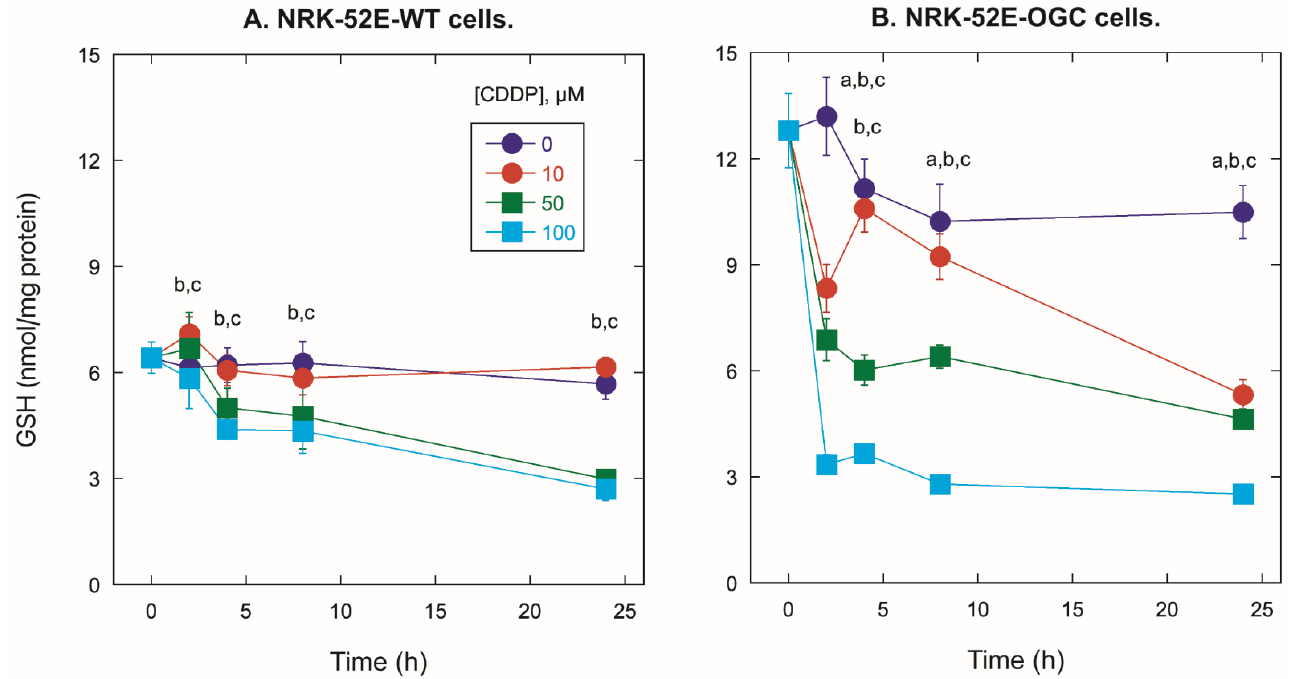
Figure 5. Time and concentration dependence of effects of CDDP on total cellular GSH concentration. Concentrations of total cellular GSH were determined in cells grown on collagen-coated T-25 flasks. After detachment at the indicated times by brief treatment with trypsin/EDTA, GSH content was determined by ion-exchange high-pressure liquid chromatography after derivatization with iodoacetic acid and 1-fluoro-2,4-dinitrobenzene. Results are means ± SEM of measurements from 3 separate cell cultures for NRK-52E-WT cells ( A ) and NRK-52E-OGC cells ( B ). a,b,c = Significantly different ( p < 0.05) from 0-µM control for 10, 50, and 100 µM CDDP, respectively, at the same time point.